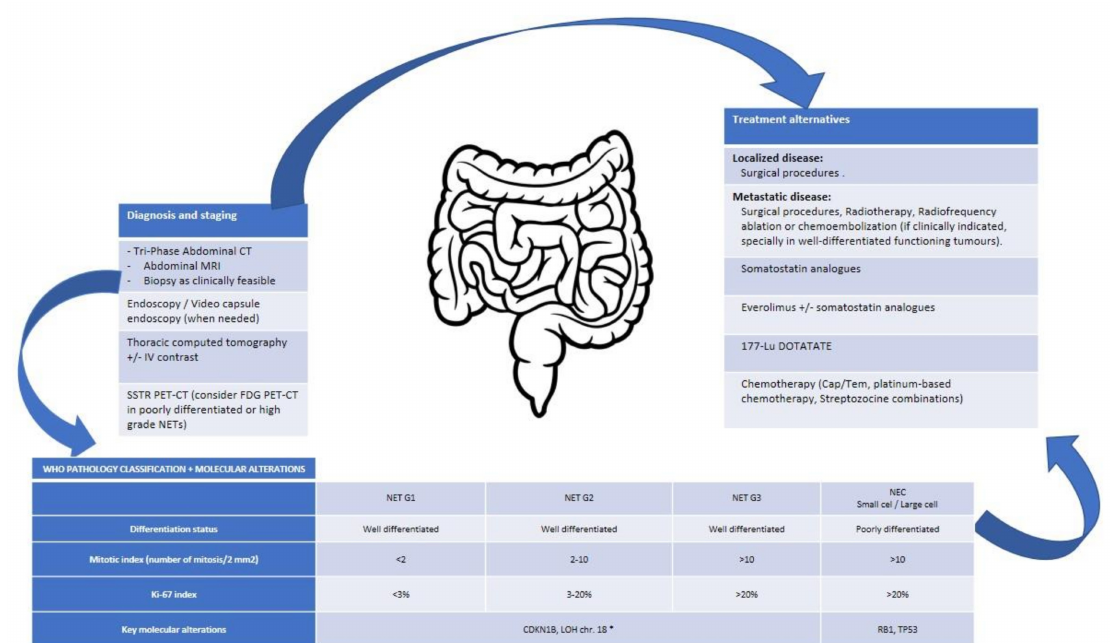
Figure 5. Integrative algorithm of current management in SI NENs.* No specific data for NET-G3 available. Cap/Tem, capecitabine/Temozolomide; chr., chromosome; CT, computed tomography; FDG, fluorodeoxyglucose; G, grade; IV, intravenous; LOH, loss of heterozygosity; MRI, magnetic resonance imaging; NEC, neuroendocrine carcinoma; NET, neuroendocrine tumour; PET-CT, positron emission tomography-computed tomography; sd., syndrome; SSTR, somatostatin